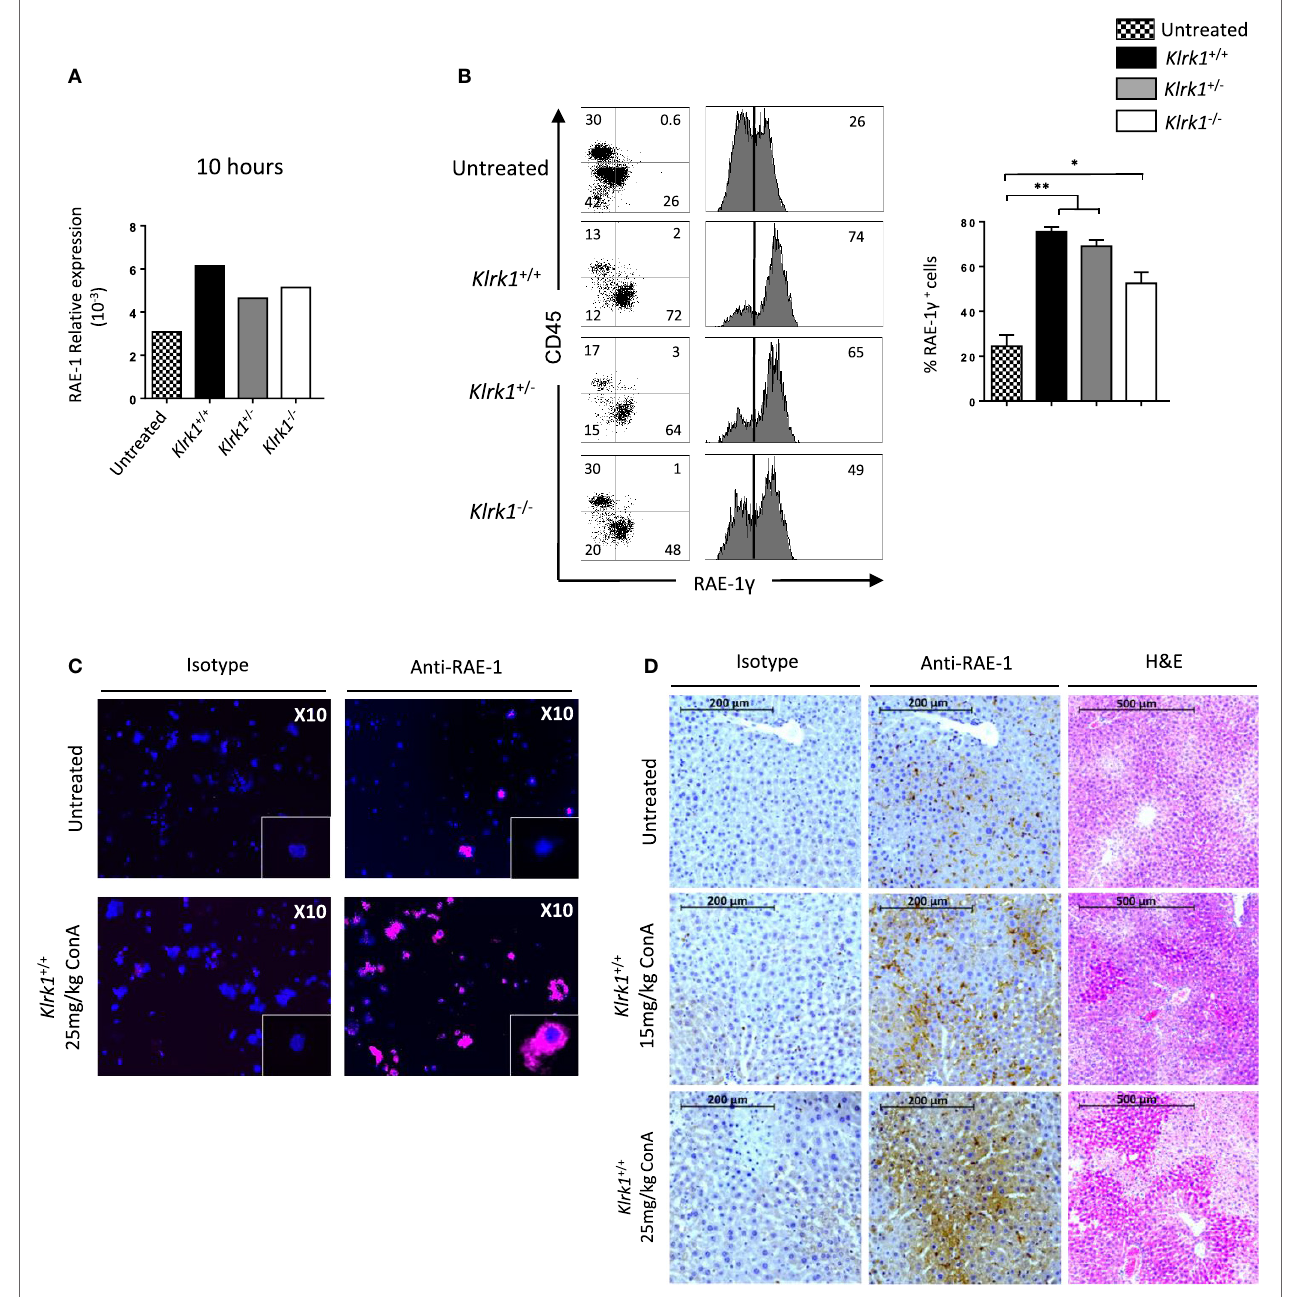
FigUre 7 | Retinoic acid early inducible 1 (RAE-1) expression is upregulated upon concanavalin A (Con A) administration in vivo (a) . Relative expression of RAE-1 transcript in liver tissue in non-injected, or 10 h after Con A administration (25 mg/kg). (B) Representative histogram staining of RAE-1 expression at the cell-surface of hepatocytes in non-injected or after 8 h after Con A administration (25 mg/kg). (c) RAE-1 expression assessed in hepatocytes by fluorescent microscopy in non-injected or 3 h after Con A administration (25 mg/kg). (D) Histological examination of RAE-1 expression on hepatic sections from mice non-injected or 8 h after Con A administration (15 or 25 mg/kg). Note that increased doses of Con A correlate with increased RAE-1 expression and liver degenerative changes as assessed by H&E staining. Results are from four experiments where three mice of the indicated genotype were used per experiment and presented as mean ± SD. Significance is represented by an asterisk and was evaluated with non-parametric Mann–Whitney U